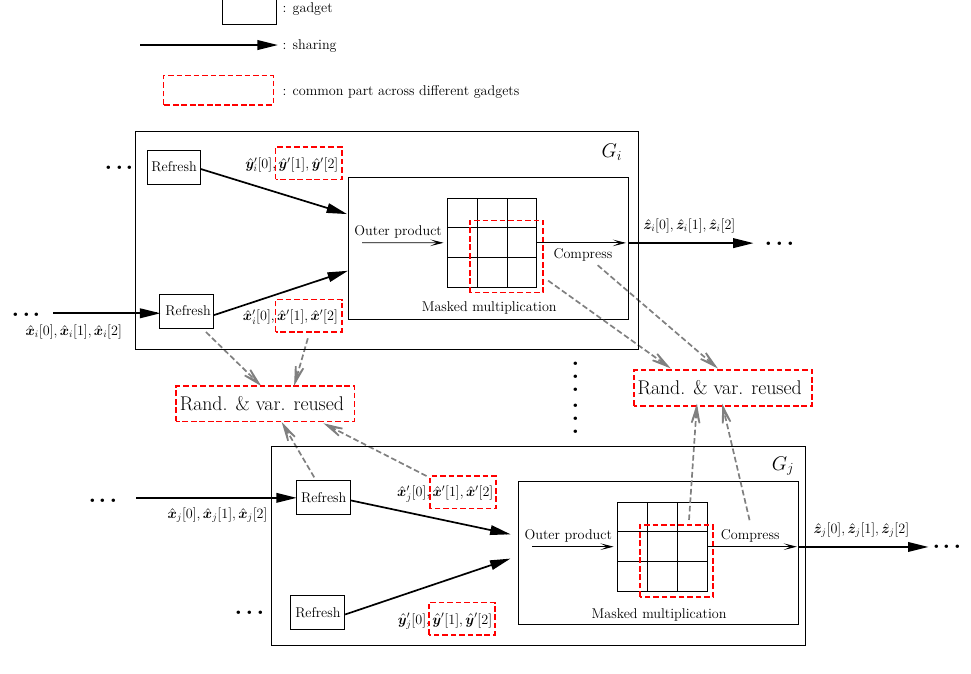
Figure 2: Concept of our scheme with security order d =